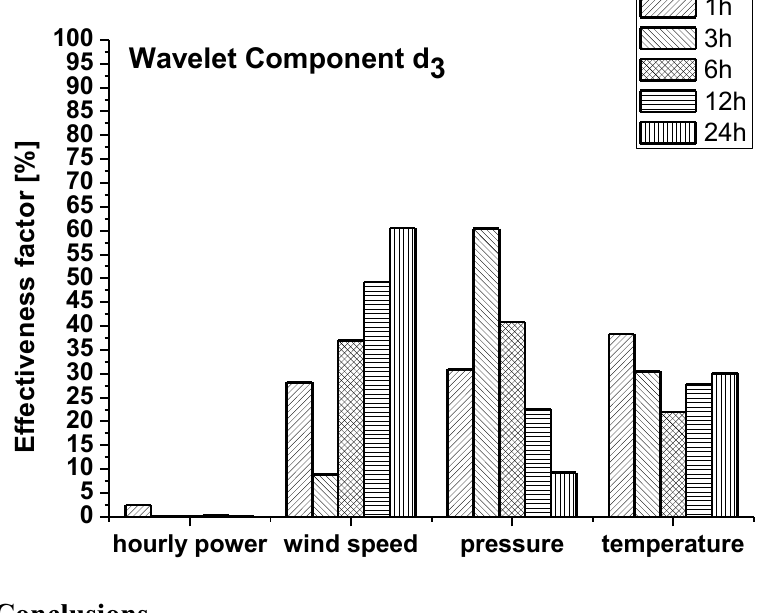
Figure 15. Histogram of the effectiveness factors for the detail component d